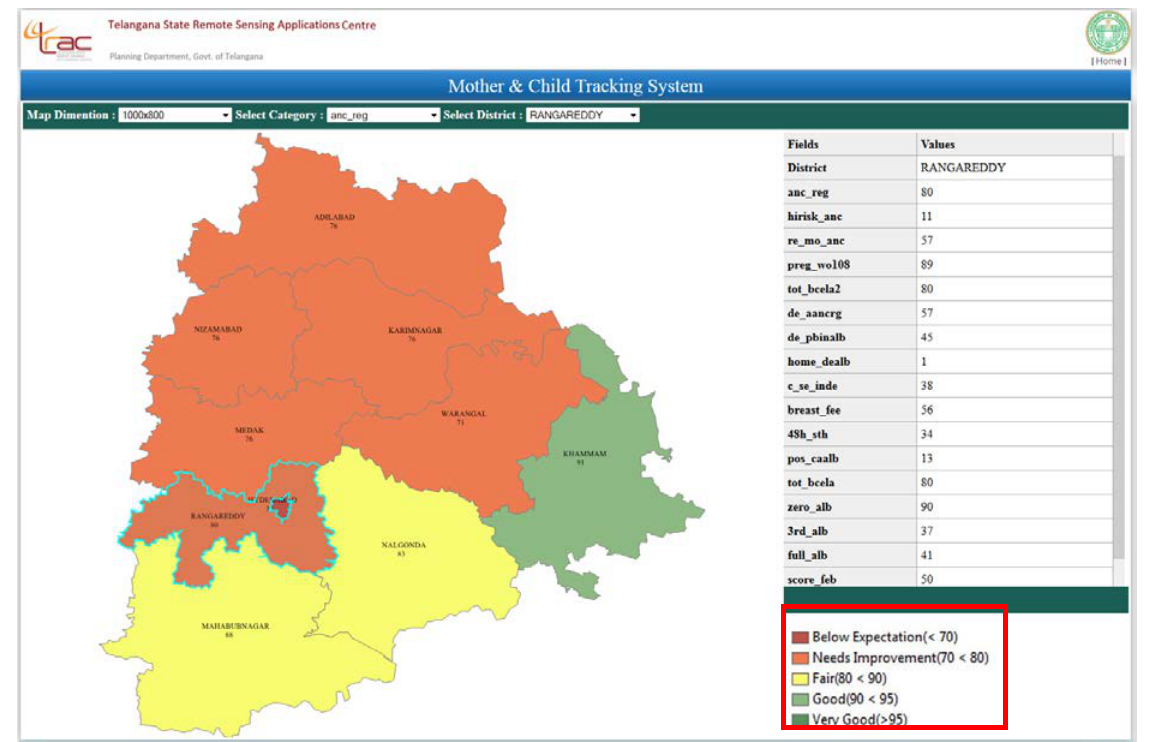
Figure 1: Web interface for Mother and Child Tracking System